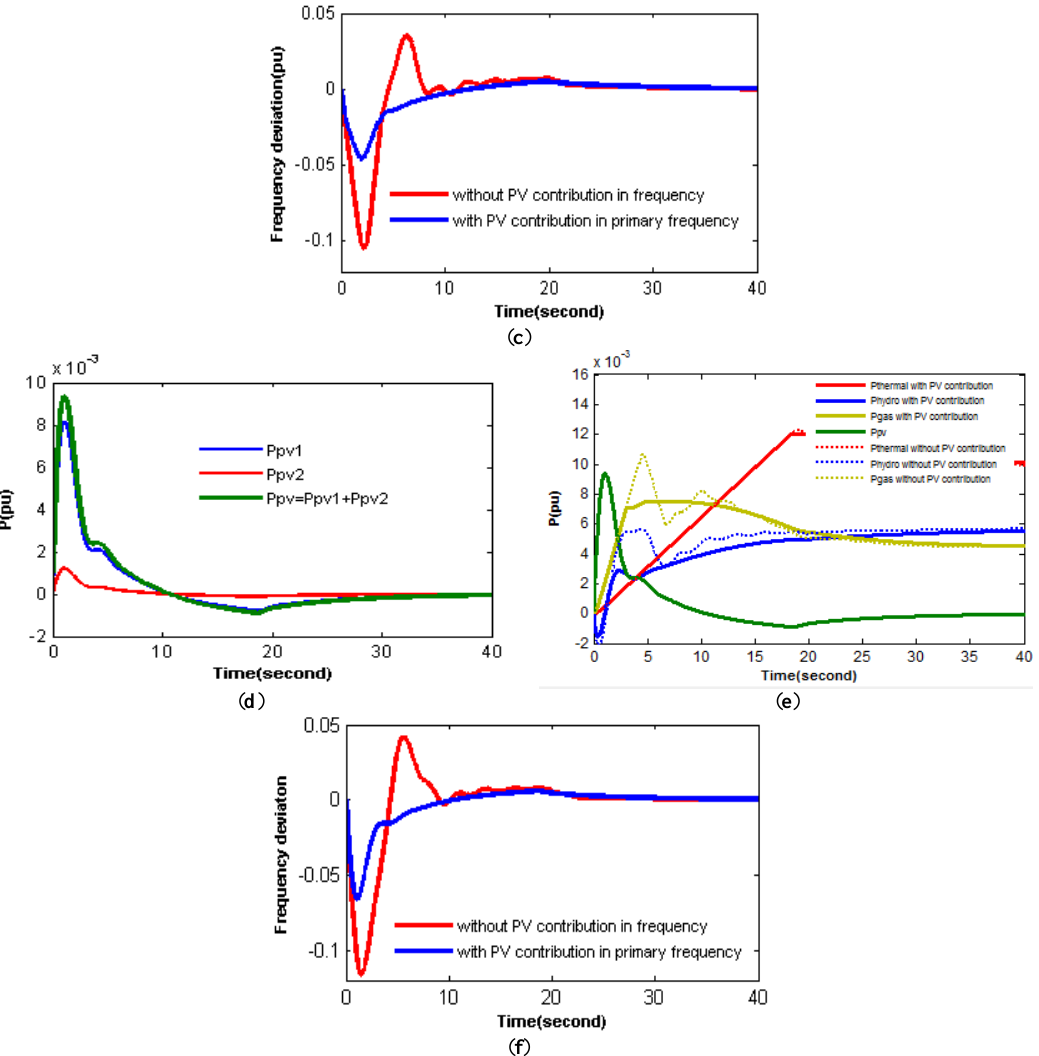
Figure 11. The system response to PV contribution in the initial part of primary frequency control with a 1% rise in step load in power system area 1 and a 2% rise in step load in power system area 2: ( a ) Power variation of the PV modules in area 1; ( b ) Power variation in different units in area 1; ( c ) Frequency of the system in area 1; ( d ) Power variation of the PV modules in area 2; ( e ) Power variation in different units in area 1; ( f ) Frequency of the system in area 2 .